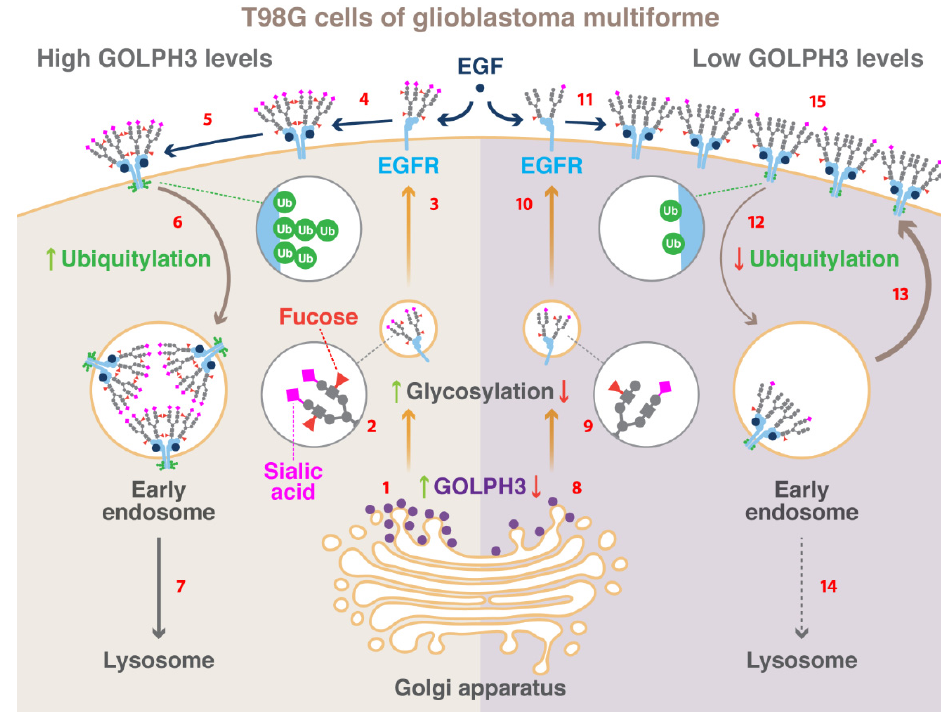
Figure 10. Schematic model of GOLPH3 levels affects glycosylation, ubiquitylation, and trafficking of EGFR in T98G cells. (Left side) Newly synthesized EGFR in T98G cells, which expresses high GOLPH3 levels ( 1 ), undergoes N -glycosylation in the Golgi apparatus, including terminal sialylation and fucosylation ( 2 ). Monomeric EGFR reaches the cell surface ( 3 ). Upon binding to EGF, EGFR dimerization takes place ( 4 ) followed by ubiquitylation of its cytosolic domain ( 5 ). EGFR internalizes into early endosomes ( 6 ) en route to lysosomes for degradation ( 7 ). (Right side) Lowering of GOLPH3 levels in T98G cells ( 8 ) causes a decrease in terminal sialylation and fucosylation of newly synthesized EGFR ( 9 ) without affecting its net trafficking to the cell surface ( 10 ). At the cell surface, EGF binds to EGFR causing its apparent normal dimerization ( 11 ); however, ubiquitylation of its cytosolic domain is greatly reduced ( 12 ). In addition, internalized EGFR into early endosomes shows an increase in its recycling to the cell surface ( 13 ), reducing its trafficking to lysosomes for degradation ( 14 ) and leading to an increase in EGFR dimers at the cell surface ( 15 ).